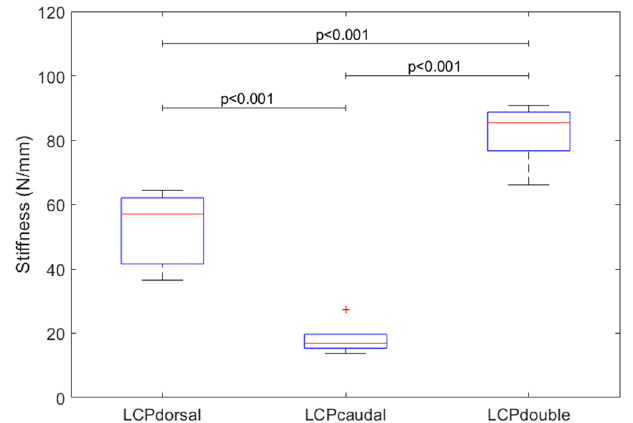
Figure 4. Stiffness of the three LCP constructs (boxplot shows median (red line), interquartile range (box), and maxima and minima (upper and lower whisker)).